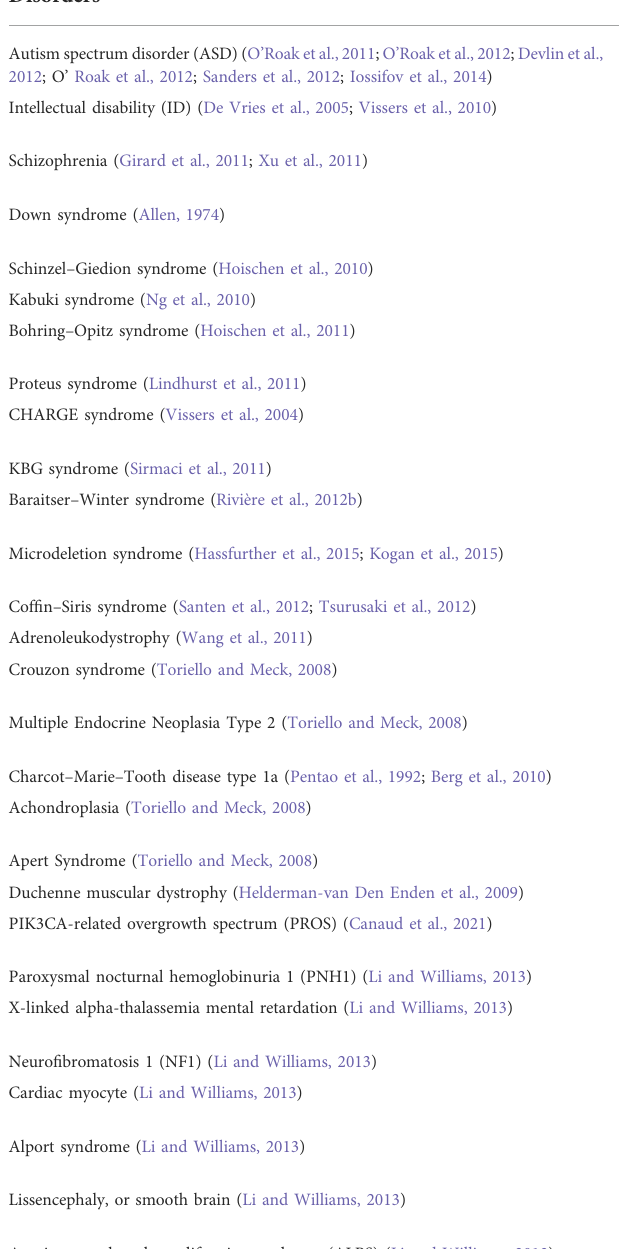
TABLE 1 List of genetic disorders caused by de novo